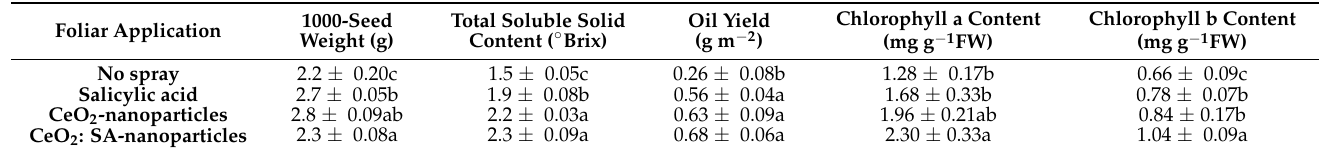
Table 4. Comparison of means for the effect of foliar applications on 1000-seed weight, total soluble solid content, chlorophyll content, and oil yield of Portulaca oleracea plants.